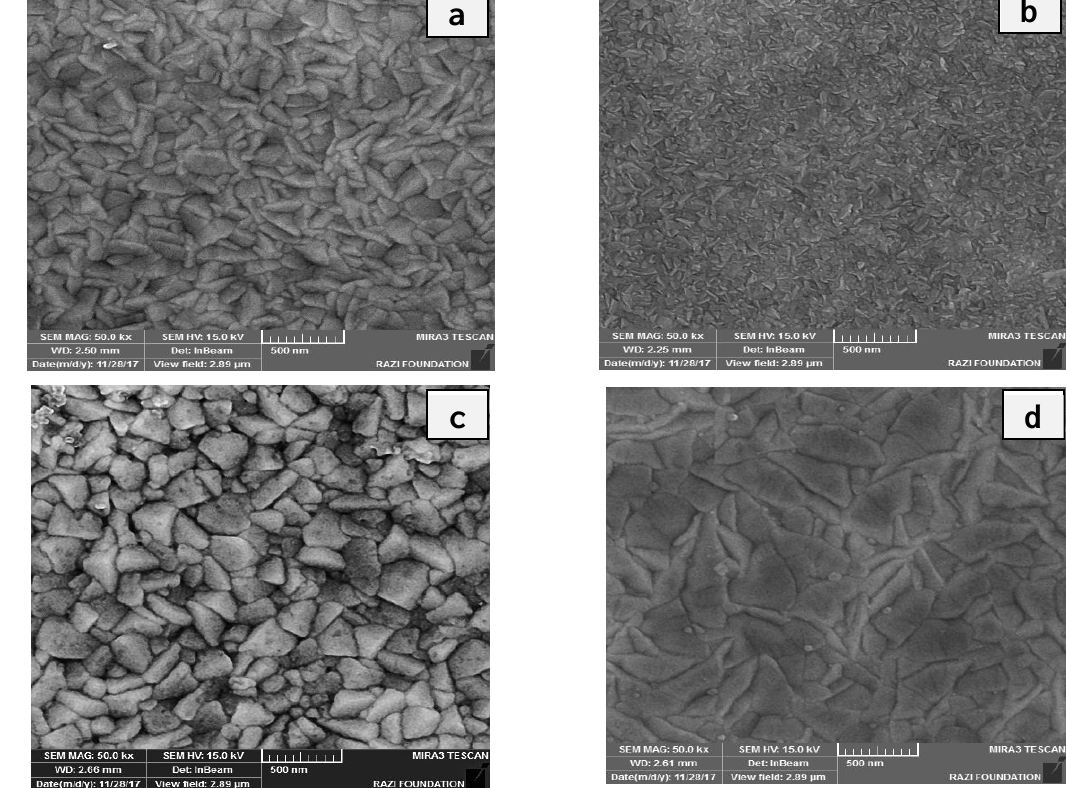
Fig.2: FESEM image of (a) pure CdS (b) CdS:Ce 10 % (c) CdS:La 10 % (d)CdS:Nd 10 %.